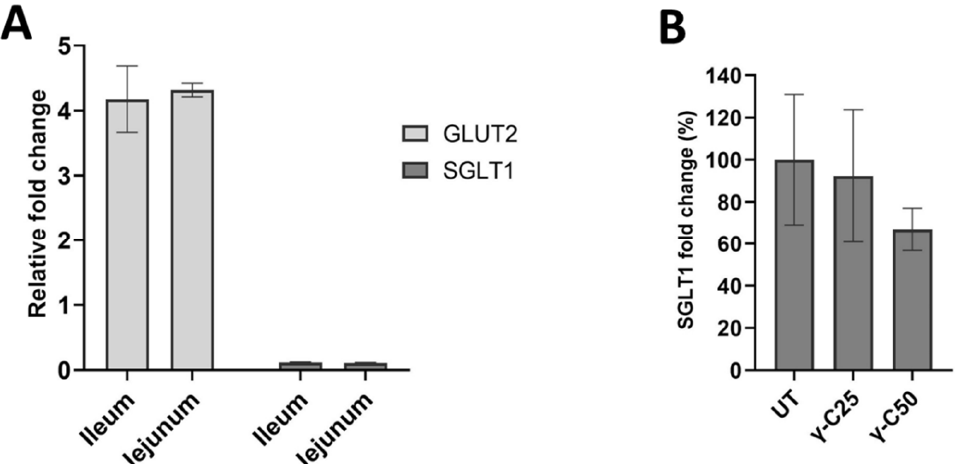
Figure 5. Expression of SGLT1 and GLUT2 glucose transporters in intestinal tissues and the IPEC-J2 cell line. ( A ) Expression fold determined by RT-qPCR of SGLT1 and GLUT2 ( p < 0.05). ( B ) Effects of the 24 h incubation of IPEC-J2 cells with 0.25 mg/mL ( v / v , γ -C/culture medium, γ -C25) and 0.50 mg/mL ( v / v , γ -C/culture medium, γ -C50 group) on SGLT1 protein expression, compared with the untreated group (UT) ( p > 0.05). Data are expressed as mean ± standard deviation.